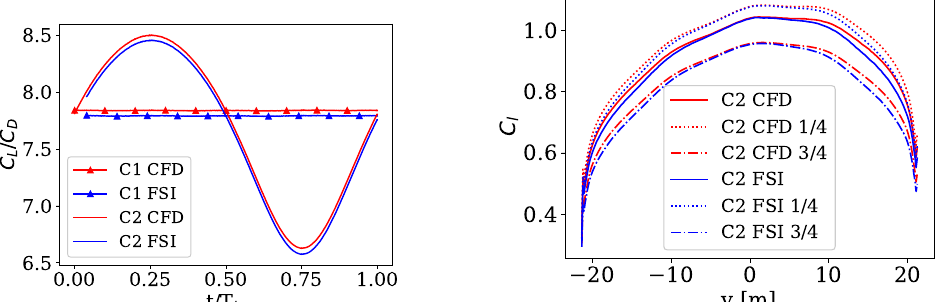
Figure 17. Lift over drag coefficients versus ( left ) time and ( right ) spanwise lift distribution, with 1/4 meaning the highest altitude and 3/4 meaning the lowest